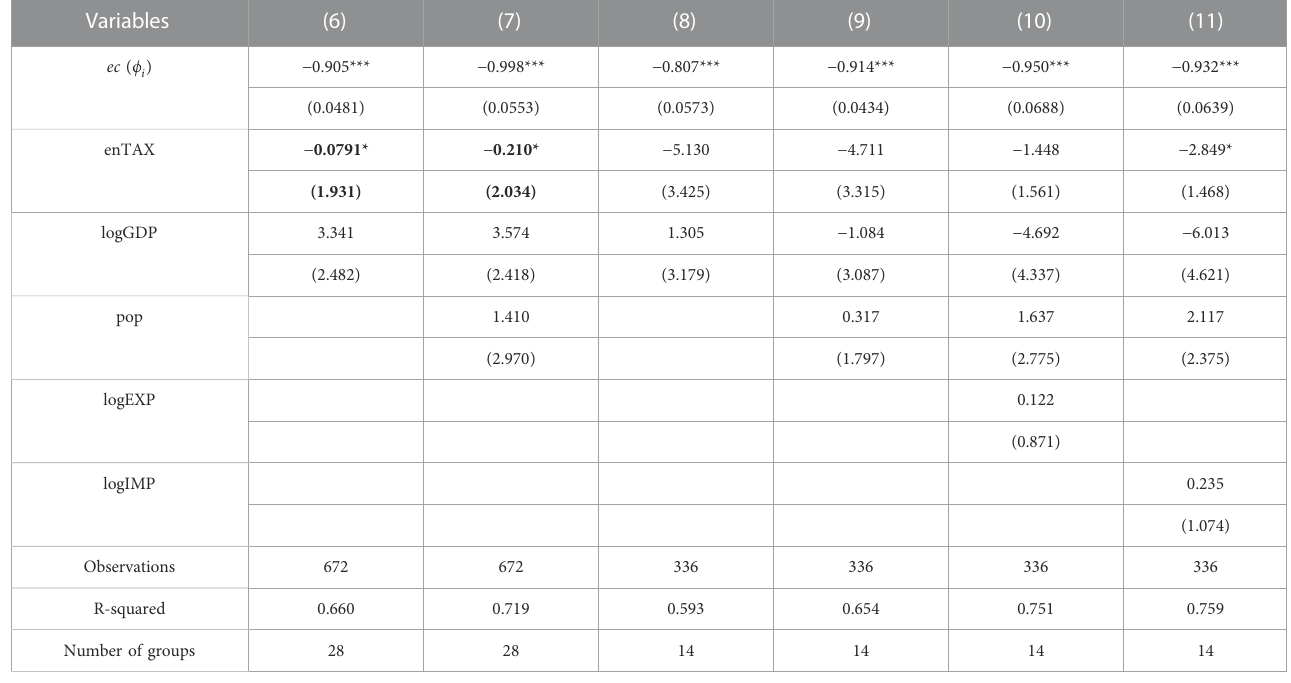
TABLE 4 Pooled mean group PMG with common-correlated effects and instrumented variables.